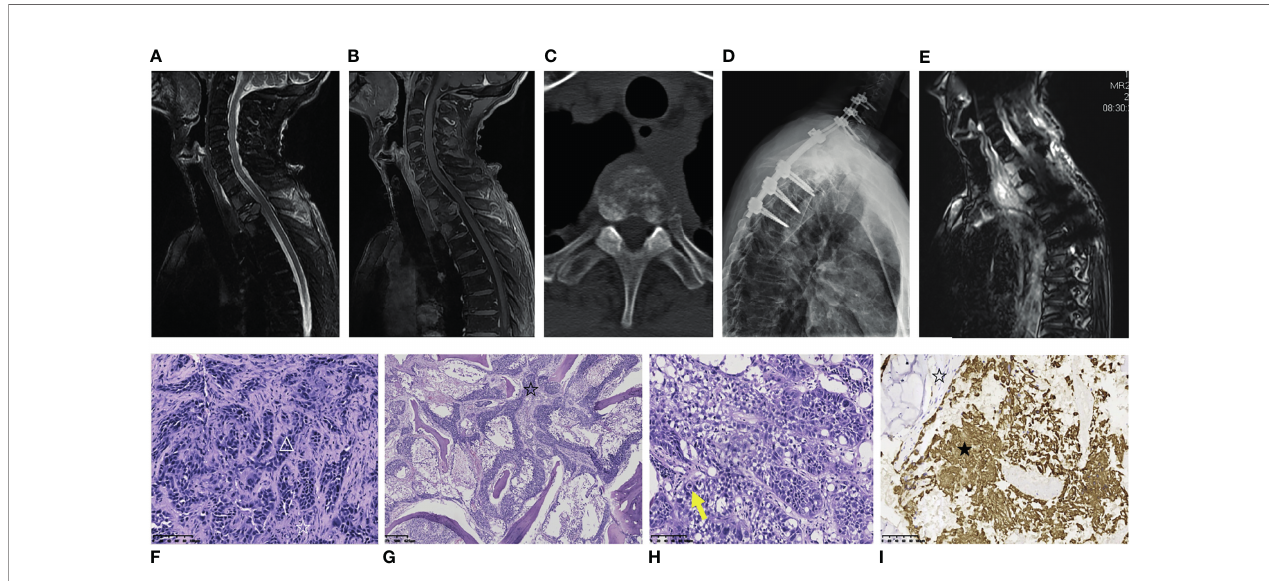
FIGURE 3 | Medical imaging, pathological and immunohistochemical pictures of metastatic thoracic adamantinoma in case 2. (A, B) MRI of the thoracic spine demonstrates vertebral body destructive changes from T1-T4 and pathologic fracture of T2 vertebral body. Thoracic lesions were T2-weighted hyperintense signal (A) , and post-contrast enhancement (B) . (C) Thoracic CT shows that the T2 lesion has a mixed lytic/sclerotic appearance with paravertebral soft tissue mass. (D) Postoperative X-ray of the spine shows the patient underwent posterior thoracic decompression (T1-T3), partial vertebrectomy (T2), posterior fi xation and fusion (C5-C7, T4-T6) with bone cement and pedicle screw. (E) Two months after surgery, contrast-enhanced MRI scan reveals an increase in osseous destruction and paravertebral mass size. (F) Microscopically, the tumor tissue was composed of prominent epithelial cell islands and admixed with bland spindle cells. Some epithelial islands were tubular cells ( △ ), surrounded by spindle-shaped fi brous stromal cells ( ☆ ) (Scale 100 m ). (G) Microscopically, the epithelial cell islands of the tumor tissue diffusely in fi ltrated between the trabecular bone in the form of nests ( ☆ ), and the trabecular bone was destroyed (Scale 100 m ). (H) Mitotic phases were uncommon (yellow arrows) (Scale 100 m ). (I) The tumor cells were positive for AE1/AE3 ( ★ ). The stromal cells were negative for AE1/AE3 ( ☆ ) (Scale 100 m